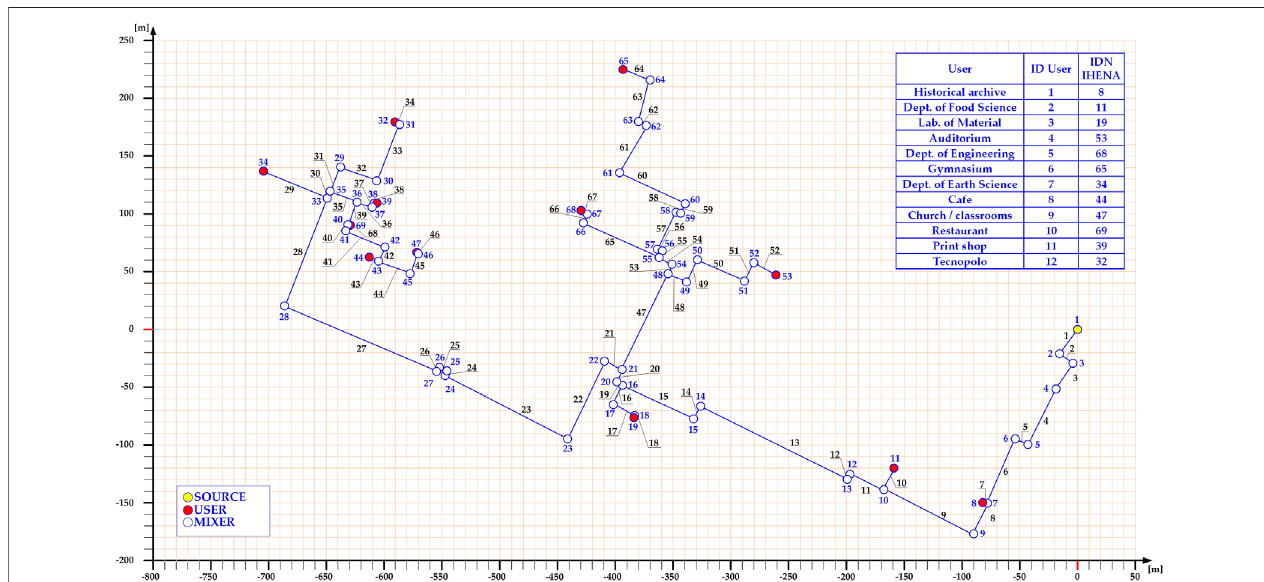
FIGURE 4 | University campus DHN implementation with software IHENA.